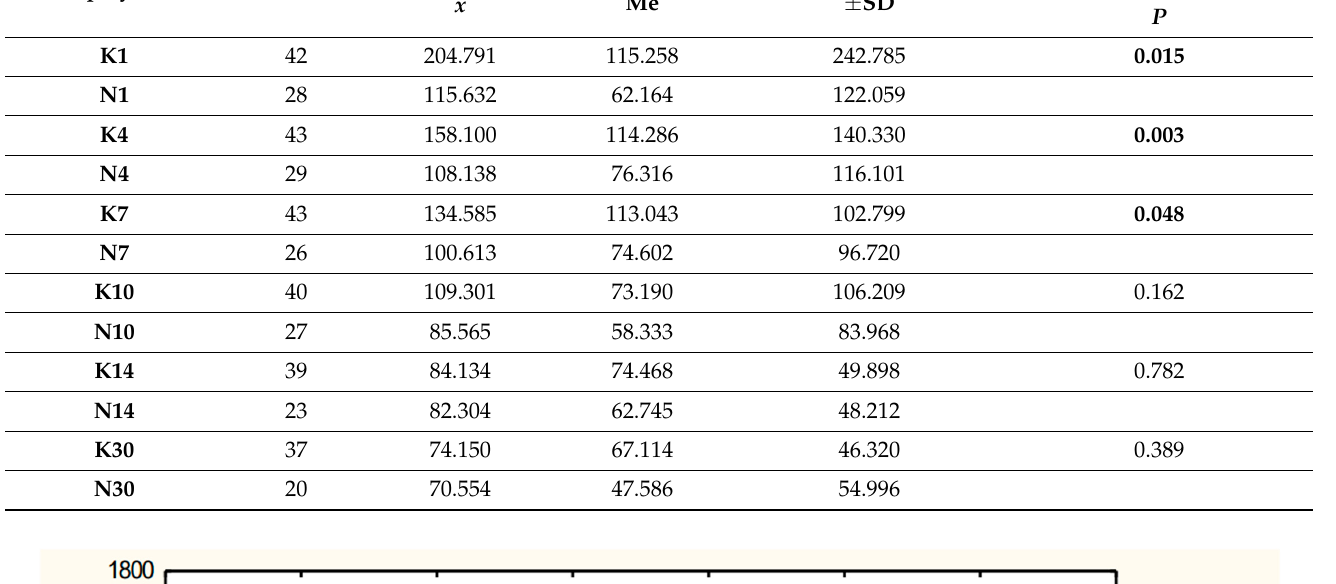
Table 3. The urinary activity of HEX ( µ Kat/kg creatinine) in those addicted to alcohol treated with neoglandin (N1-N30) and the control group which was not treated with neoglandin (K1-K30). Urine samples were collected on days 1, 4, 7, 10, 14 and 30.